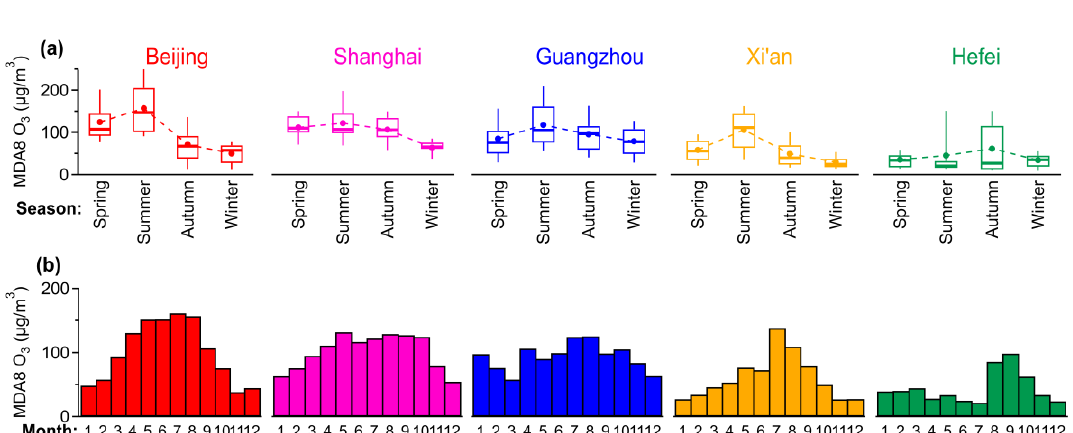
Figure 2. Seasonal ( a ) and monthly ( b ) variations of MDA8 O 3 concentrations in the five cities. The boxes represent the 25th percentile (lower edge), median (solid line), mean (dot with dashed line), and 75th percentile (upper edge). The whiskers above and below the box indicate the 90th percentile and 10th percentile.